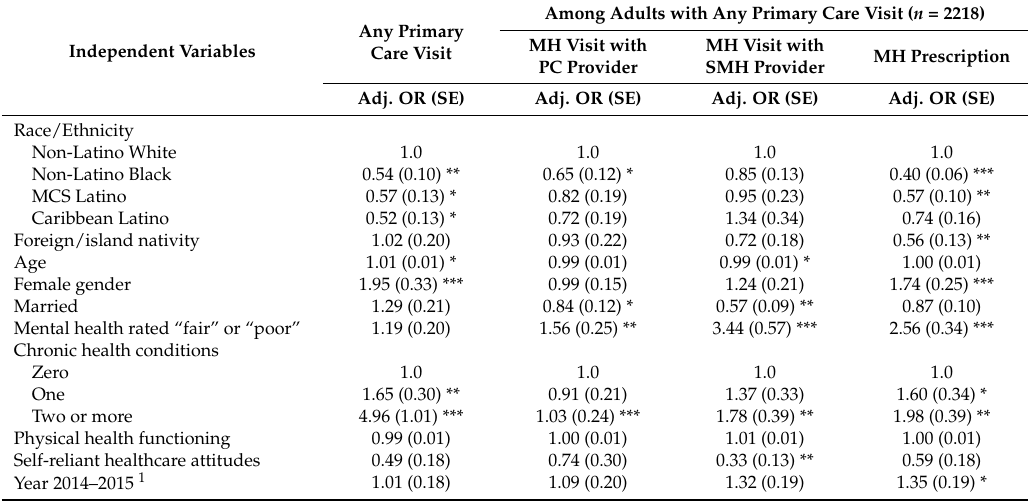
Among Adults with Any Primary Care Visit ( n = 2218) Any Primary MH Visit with MH Visit with Care Visit MH Prescription PC Provider SMH Provider Adj. OR (SE) Adj. OR (SE) Adj. OR (SE) Adj. OR (SE)